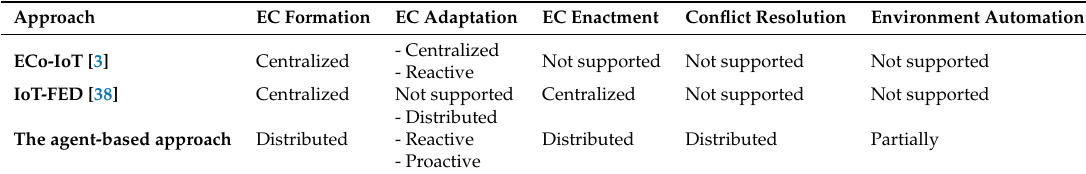
Table 5. A comparison with the approaches proposed in References